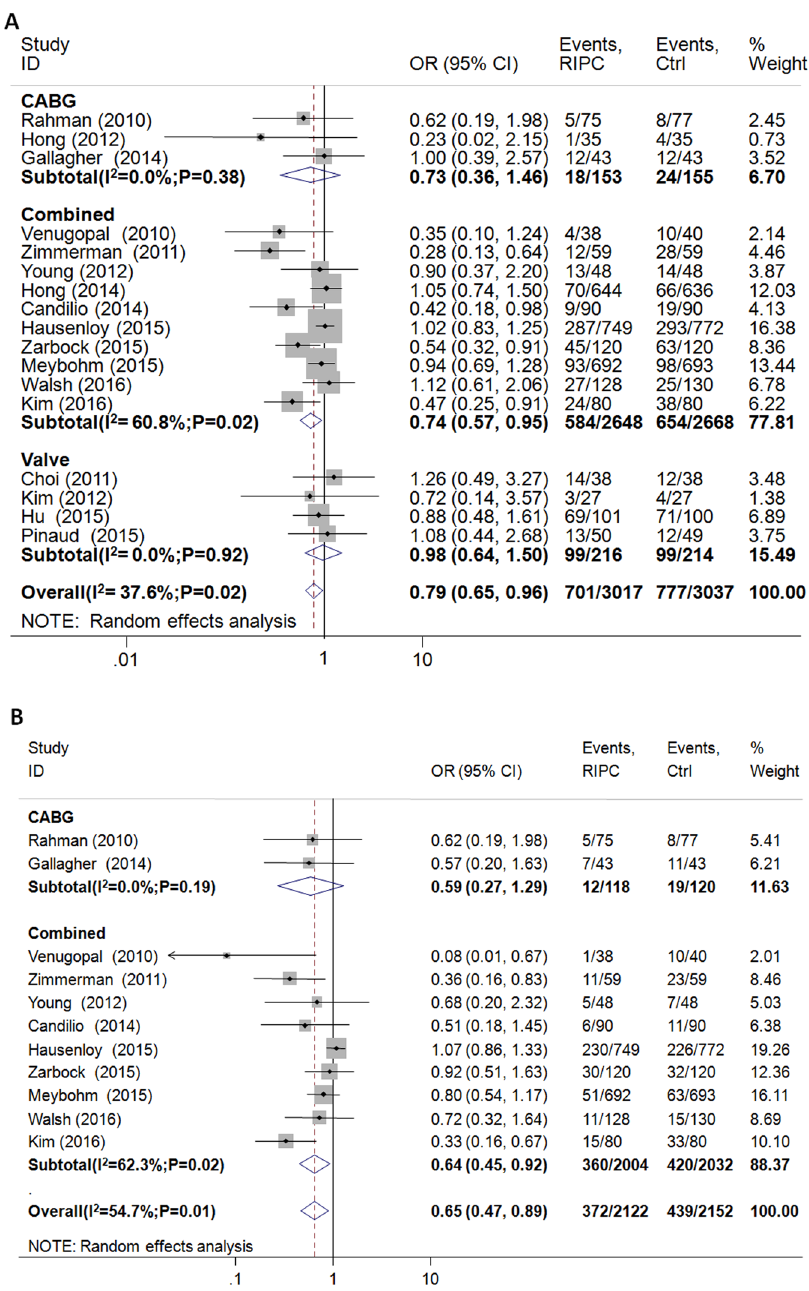
Figure 2. Forest plot of the effect on RIPC on ( A ) AKI and ( B ) AKI stage